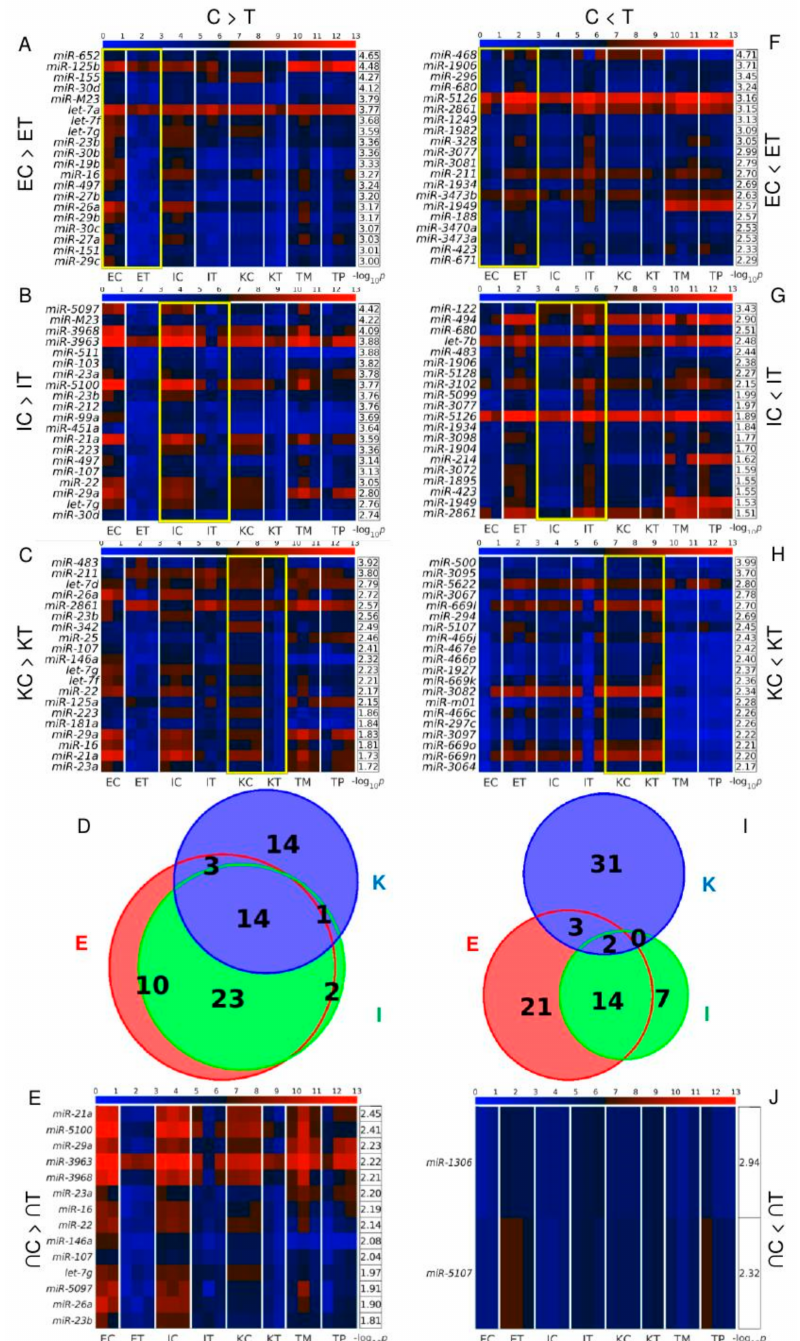
Figure 2. Di ff erentially expressed miRNAs (DEMs) between control and TME cells. Heatmaps of the expression of the 20 top-ranked in decreasing order of significance, TME DEMs: ( A – C )